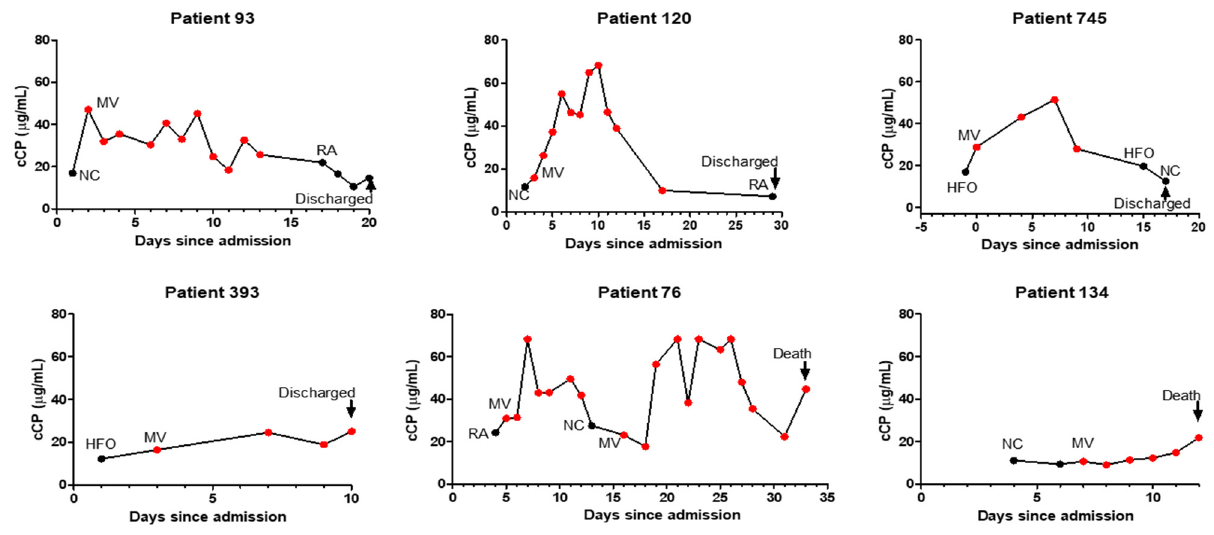
Figure 2. Profiles of longitudinal changes, corresponding respiratory supplementation, and final outcomes of representative patients with COVID-19. Abbreviations: RA, room air; NC, nasal cannula; HFO, high ‐ flow oxygen; MV, mechanical ventilation.